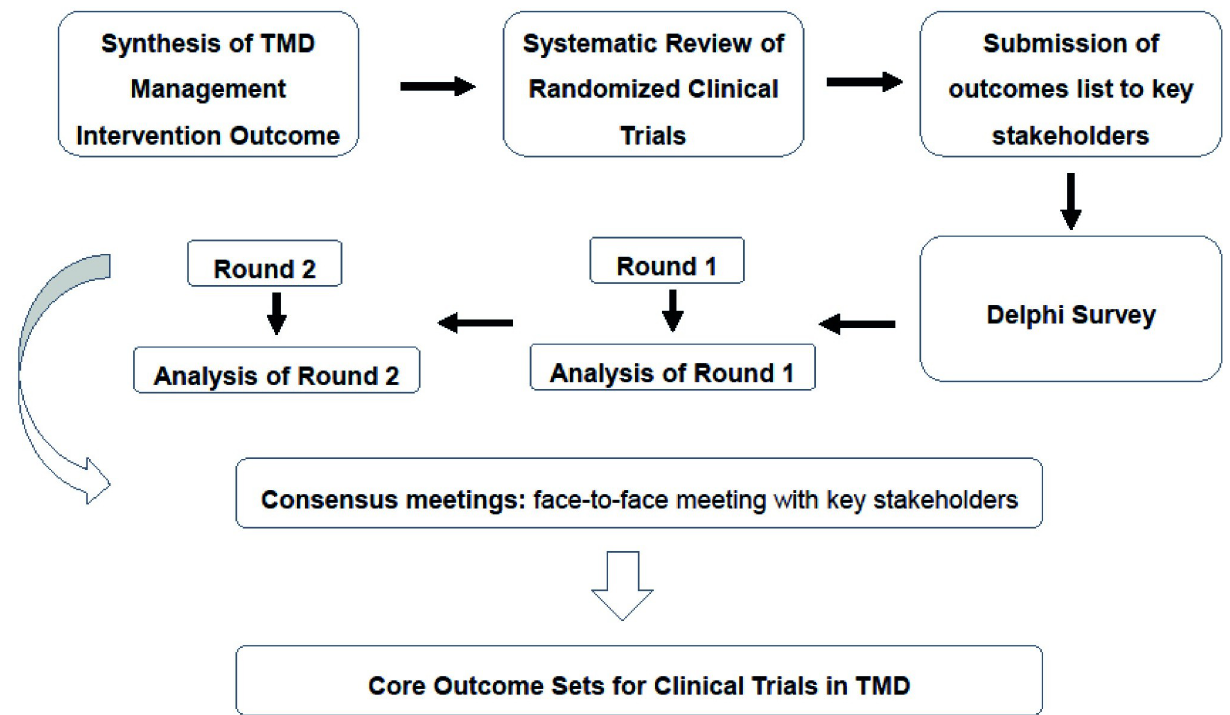
Fig 1. Flow-chart illustrating the COS-TMD